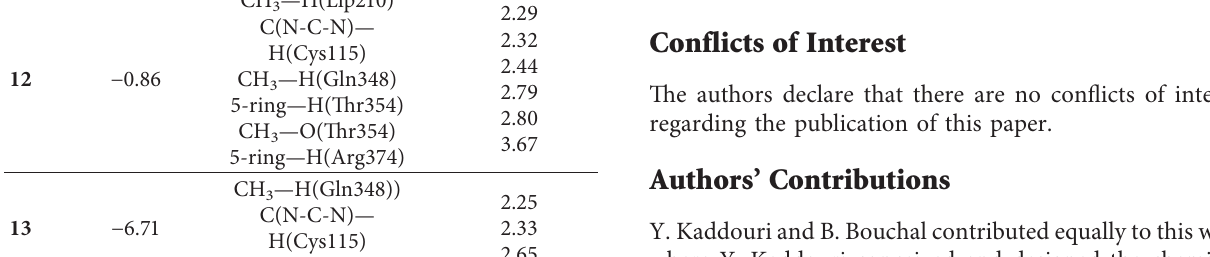
Table 5: Score, interactions, and bond length obtained for com- pounds 12 and 13 with MGL enzyme. Δ G binding in Entry kcal/mol